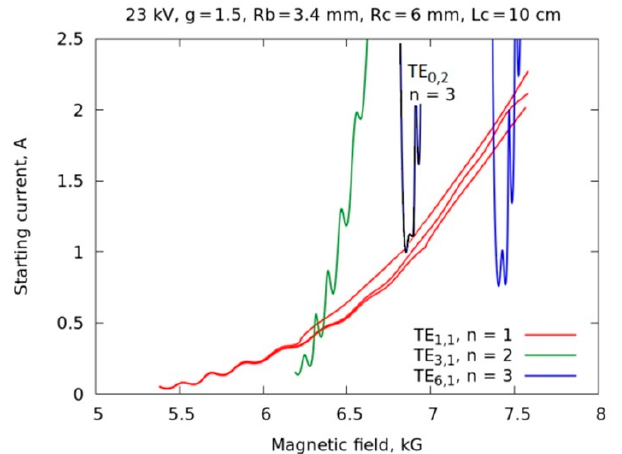
Figure 16. Results of the simulations of a technological gyrotron (beam voltage 23 kV, pitch factor g = 1.5, beam radius R b = 3.4 mm, cavity radius R c = 64 mm, and length L c = 10 cm). Starting currents of modes on different cyclotron harmonics.